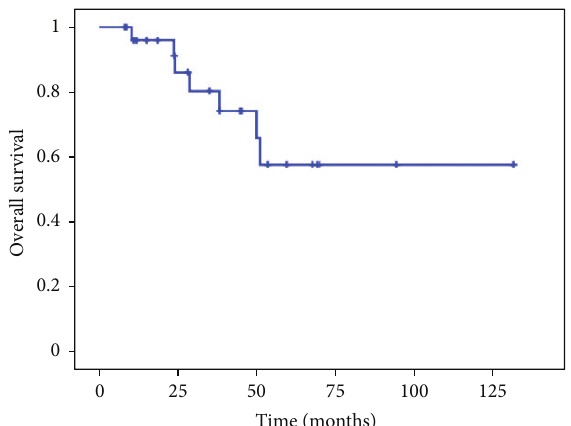
Figure 5: Kaplan-Meier plot showing the overall survival of all